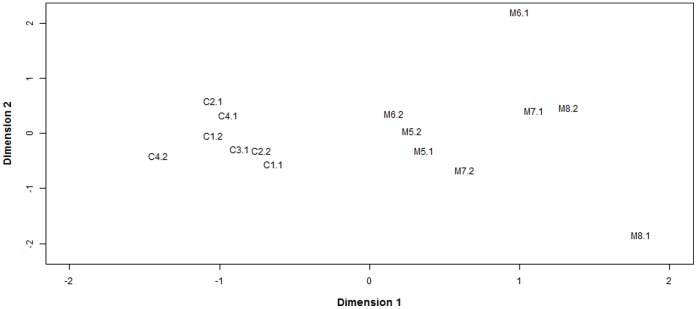
Multidimensional scaling (MDS) plot showing the relative similarities of the samples under study.Distance between each pair of samples is the square root of the common dispersion based on the top 1,000 genes that best distinguished that pair of samples.